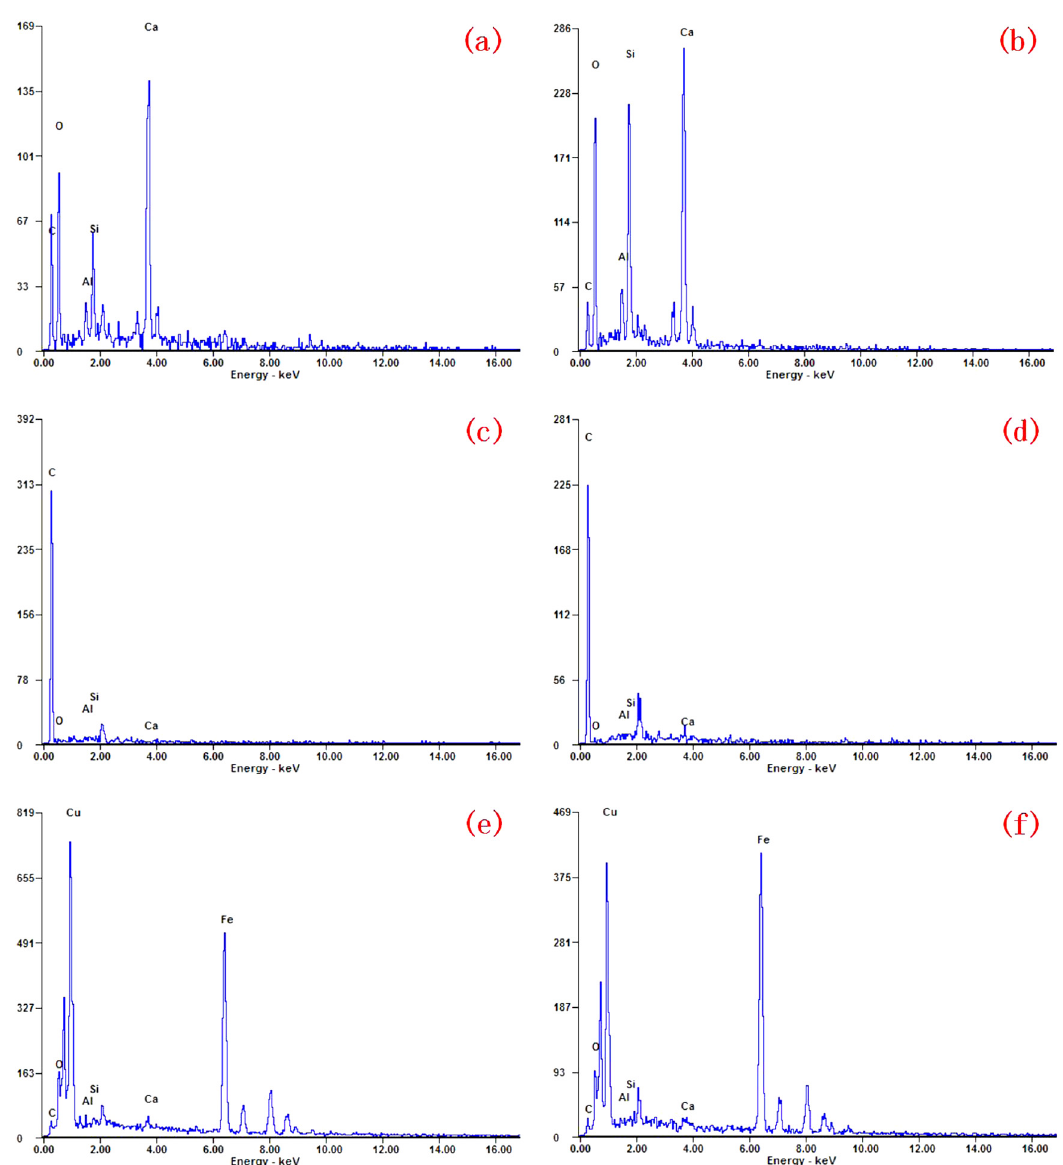
Figure 18: EDS spectrum of the fi ber surface: ( a ) point 1, ( b ) point 2, ( c ) point 3, ( d ) point 4, ( e ) point 5, and ( f ) point 6.